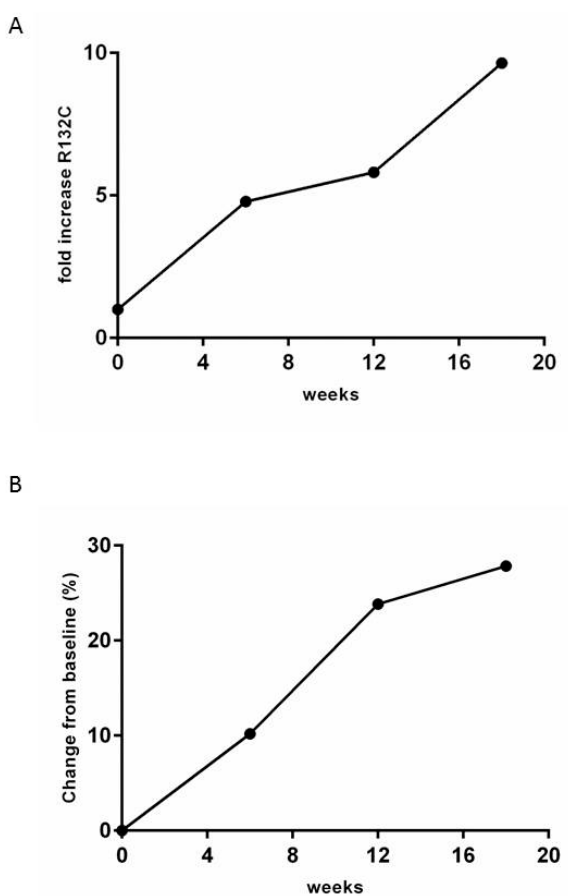
Figure 6. ( A ) Fold increase values of mutated allele in seriate longitudinal plasma samples collected every 6 weeks. The value is obtained normalizing on T0. ( B ) Trend of tumor diameter increase of selected lesions evaluated at the baseline, and every 6 weeks by CT scan. These time-points corresponded to the plasma collection used for the evaluation of IDH1m (T0 and every 6